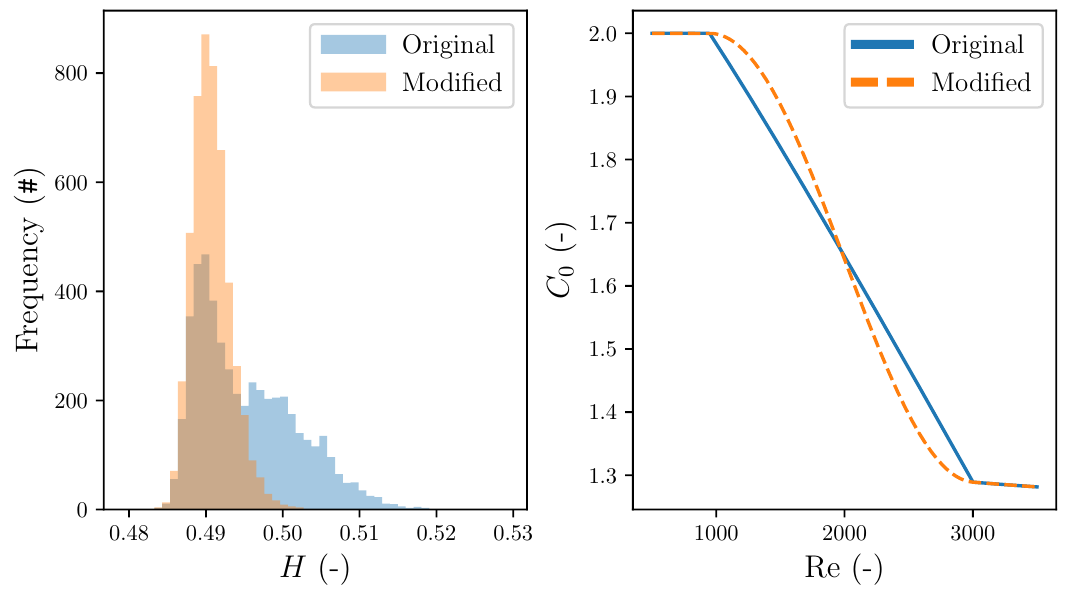
Figure 3. Comparison of two methods of interpolation by Reynolds number. ( Left ) Histograms of holdup for small perturbation of input around Re 3000 for the original model (blue) and the modified ≈ model (orange). ( Right ) The bubble nose variable C 0 ( Re ) in the transition from laminar to turbulent for the original model (blue line) and the modified model (orange dashed